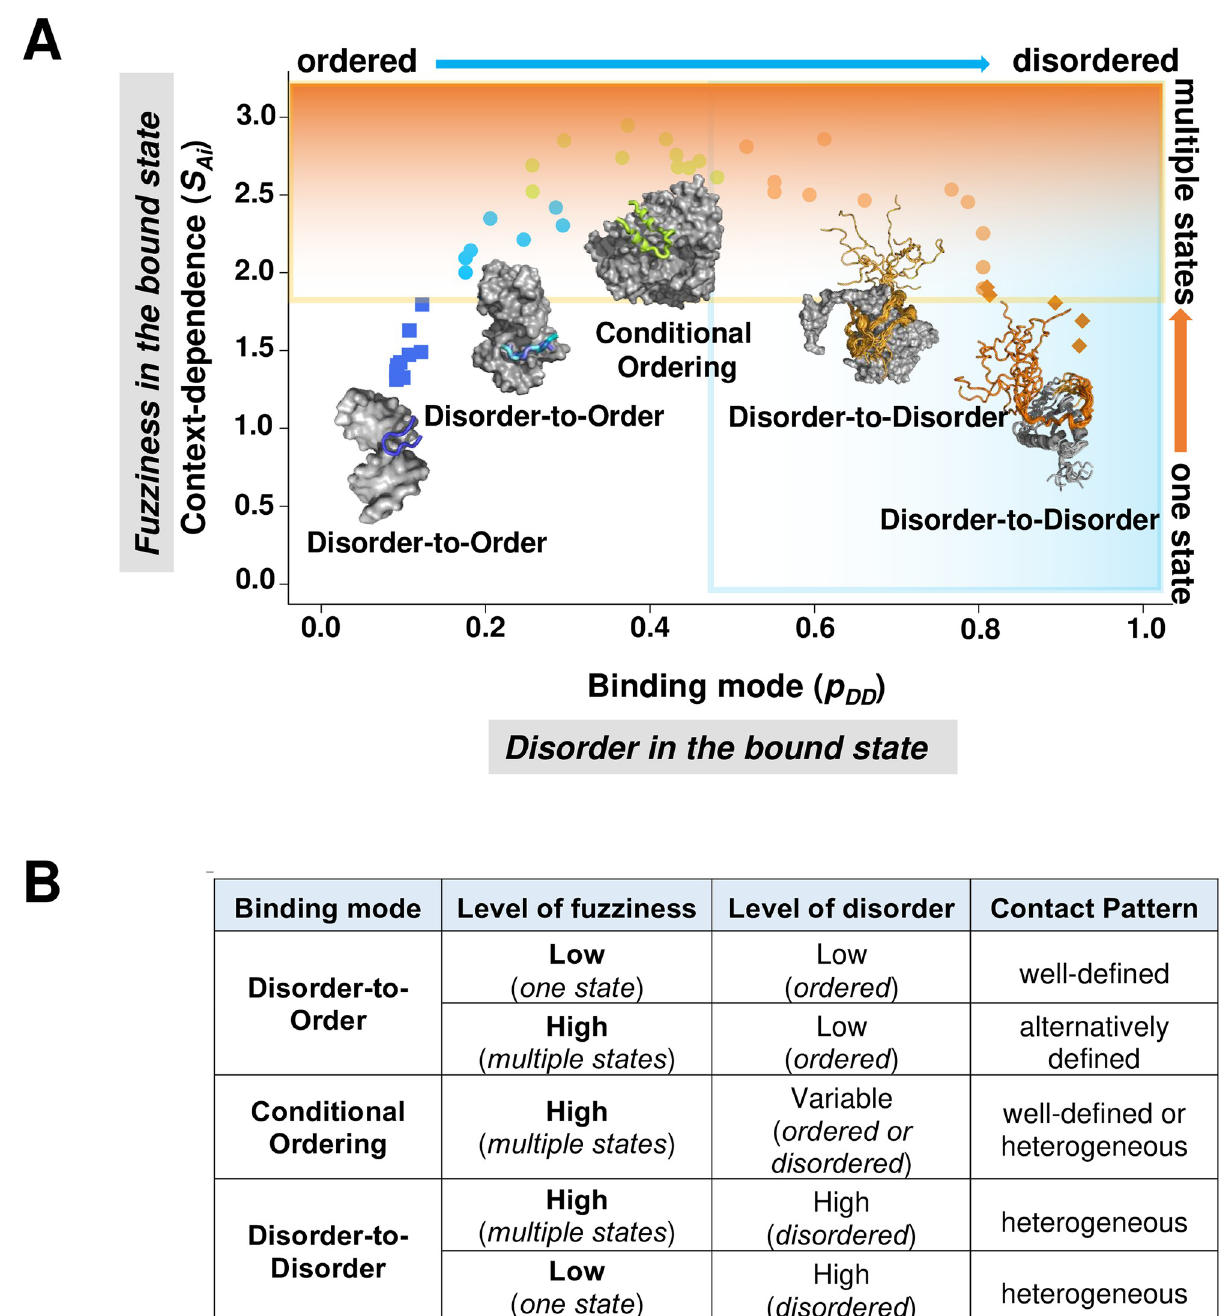
Fig 5. A binding mode landscape for disordered protein interactions. Residues are characterised by their binding modes to increase or decrease order upon interactions and the context-dependence of such binding modes. ( A ) The binding modes, reflecting the level of disorder in the bound state, are represented on the x axis; ranging from structured, well-defined to disordered, heterogeneous interactions, as quantified by the p DD values. Context- dependence, reflecting the level of fuzziness, is displayed on the y axis, ranging from stable, uniform to diverse, inducible binding modes, as quantified by the S values. The p DD and S values are predicted from the sequence by the FuzPred program. A disorder-to-order binding with low context- A i A i dependence is exemplified by a disordered loop (504–512 aa, blue squares ) in Taq polymerase, which adopts a stable structure upon interacting with DNA (PDB: 3lwl [54]). A disorder-to-disorder binding with low context-dependence is represented by the heterogeneous interactions between the elongation factor AF4 (residues 747–754, orange diamonds ) with leukemia fusion protein AF9 (PDB:2lm0 [55]). Fuzzy, context-depedent interactions sample a wide variety of binding modes ranging from disorder-to-order to disorder-to-disorder transitions. Context-dependent disorder-to-order binding is exemplified by the polymorphic interactions of the ribosomal S6 kinase 1 (RSK1, residues 697–703, light blue dots ), which adopts